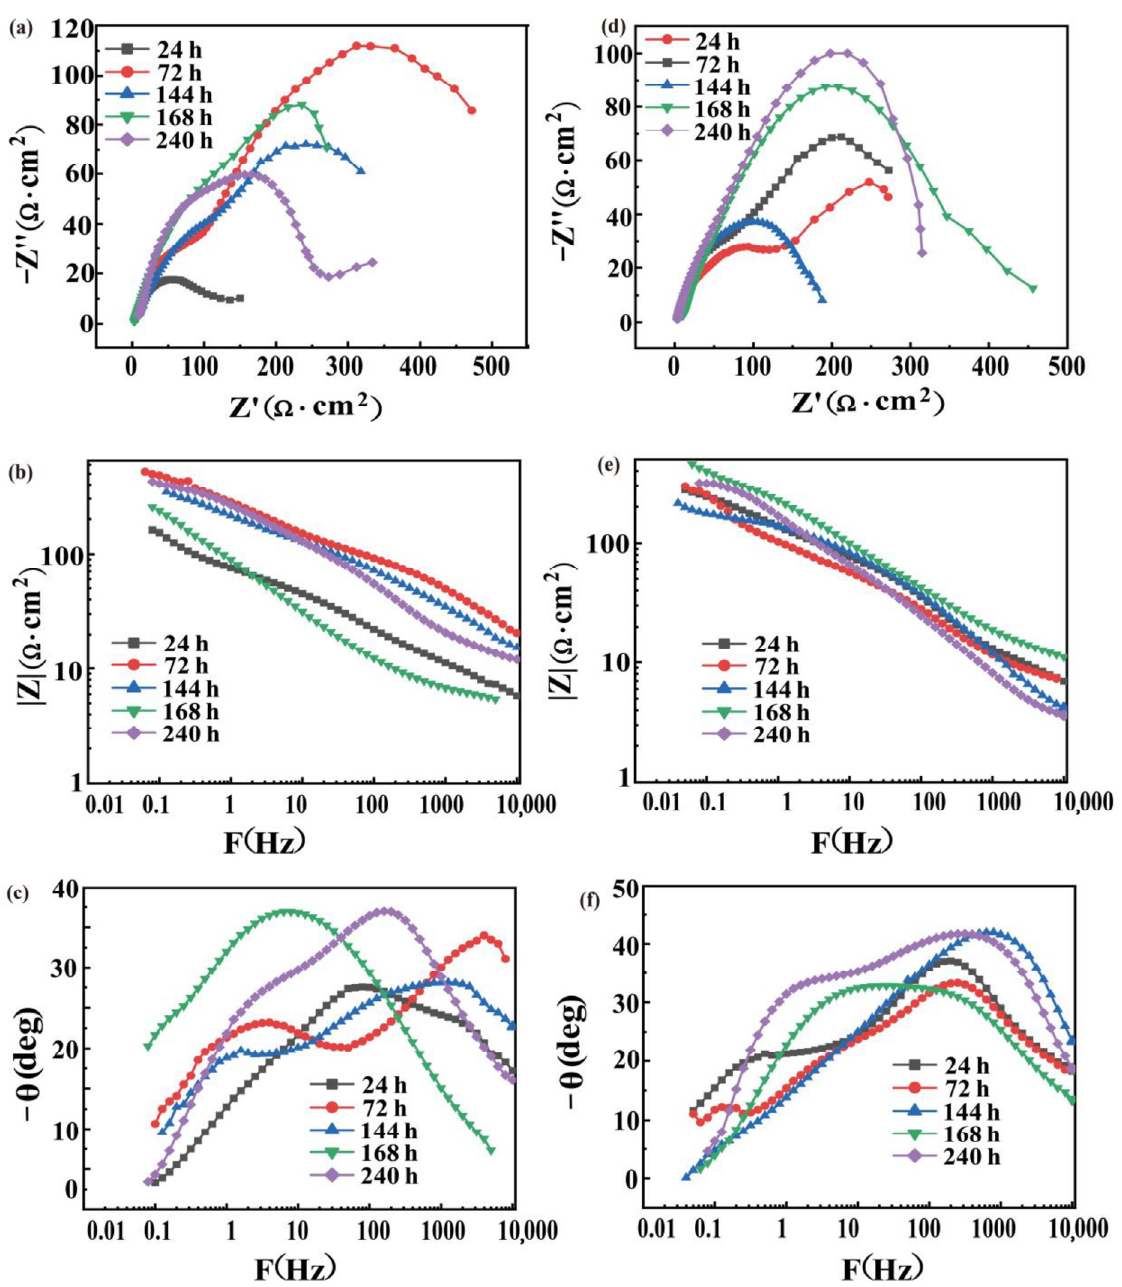
Figure 9. EIS of SiC 3D /6061Al ( a – c ) and EIS of 6061Al alloy ( d – f ) after NSS at different times: ( a , d ) Nyquist diagram; ( b , e ) Bode diagram (|Z|-F); ( c , f ) Bode diagram ( −θ -F).